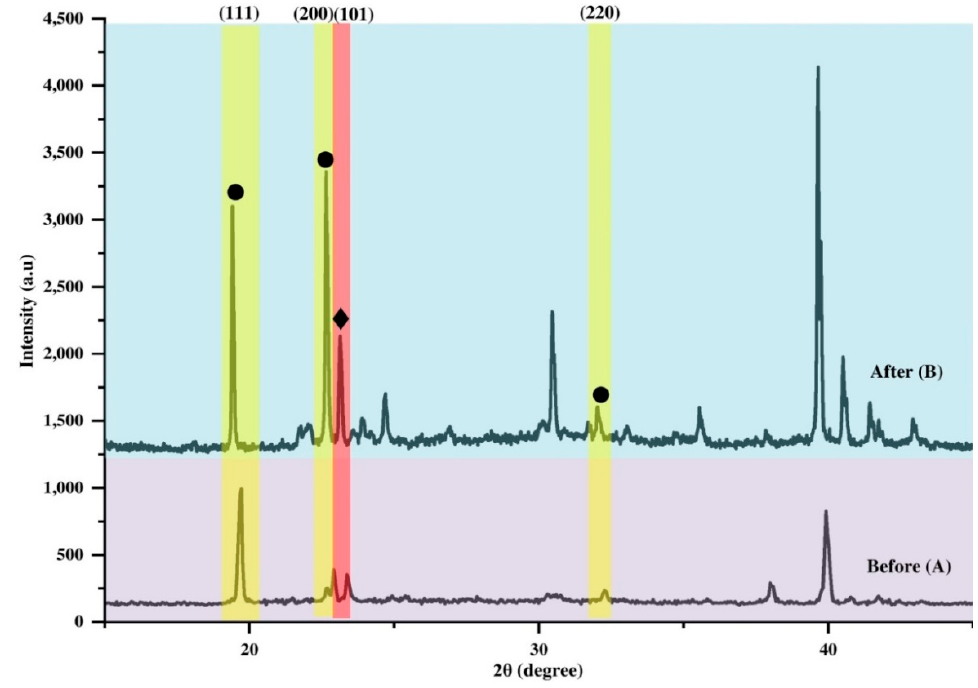
Figure 12. XRD spectrum of N ‐ AMP with ♦ marking peak of perovskite (101) and ● marking those of Pb(NO 3 ) 2 (111) (200) (220), before (A) and after exposure (B).